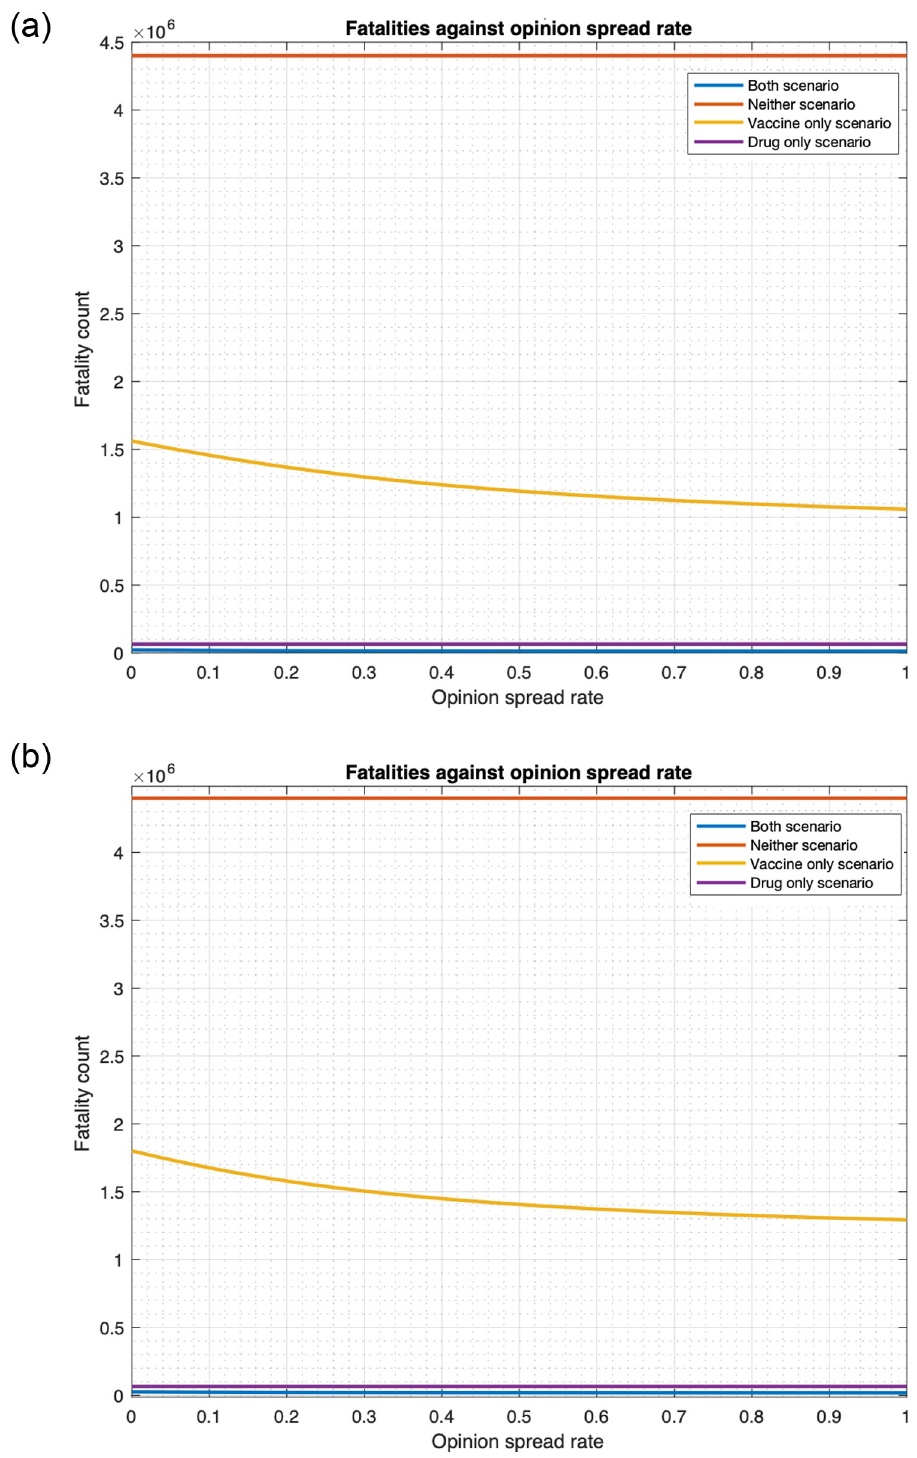
Fig 6. Relationship between fatality and opinion spread rate (single cluster). (a) Number of individuals infected at the initial time is 1,000. (b) Number of individuals infected at the initial time is 10,000.